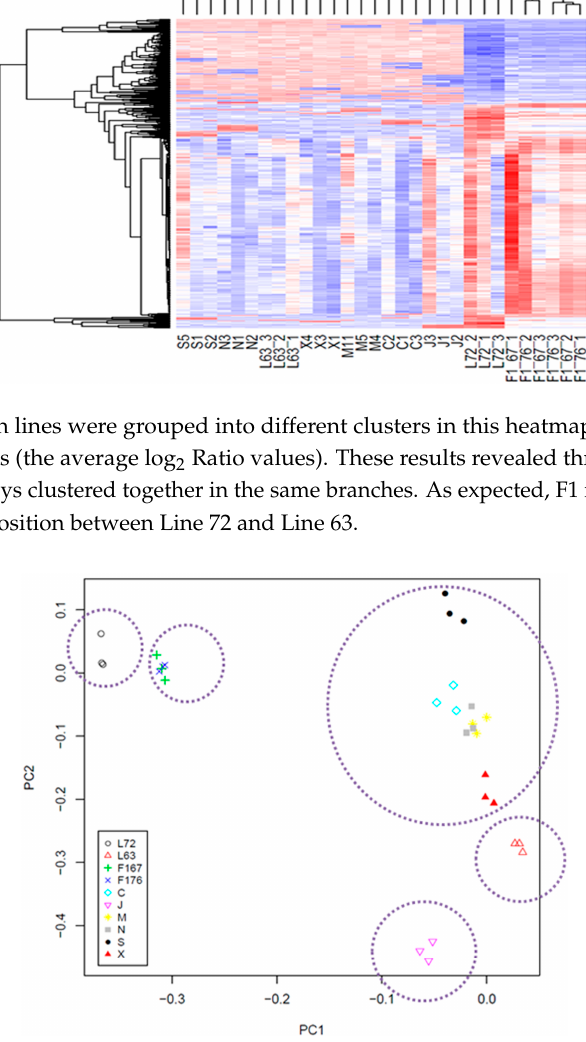
Figure 3. PCA plot based on the first two principal components in the ten inbred lines. These ten lines were clustered to approximate five groups, as indicated by dashed circles, which was consistent with their clustering results.